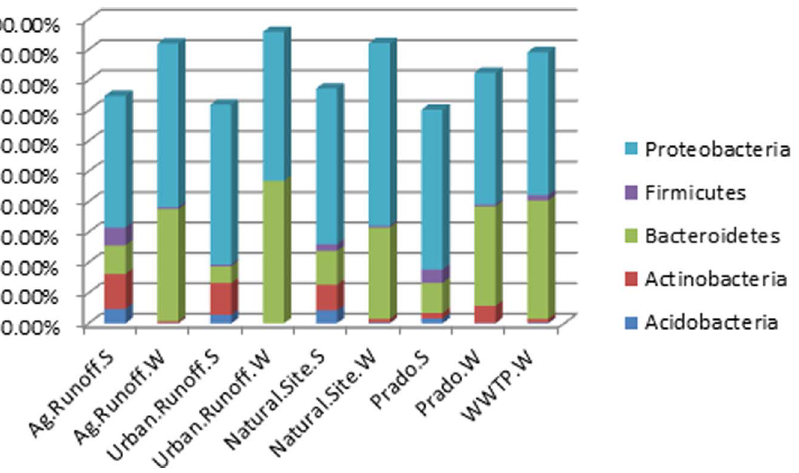
Figure 2. 16S rRNA sequence similarity to known pathogens within each genus. The five most abundant genus are shown with their distributions within each source.